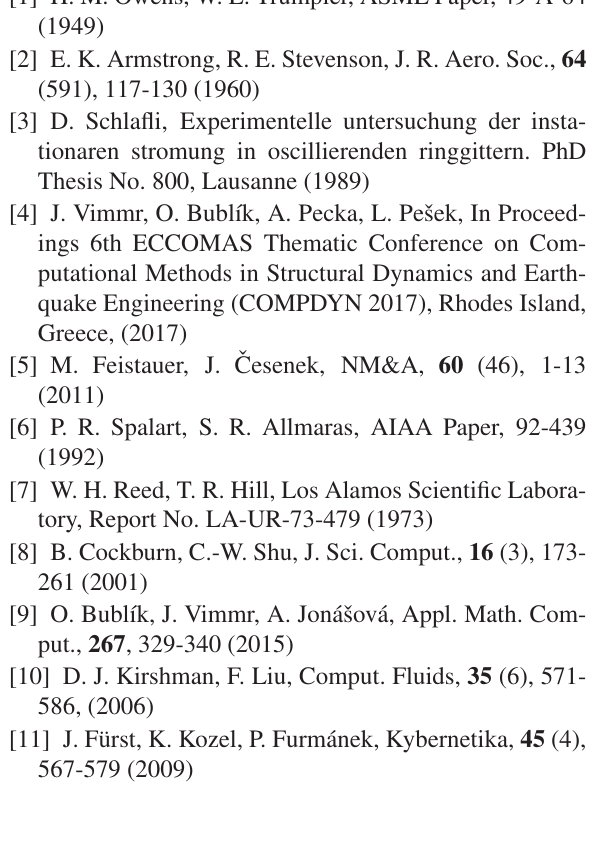
Fig. 6. PIV measured steady velocity field